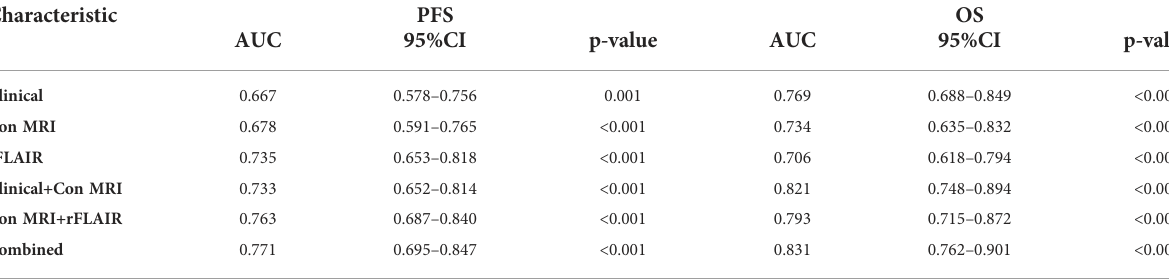
TABLE 4 ROC curve analysis of different models in survival assessment of LGG patients.